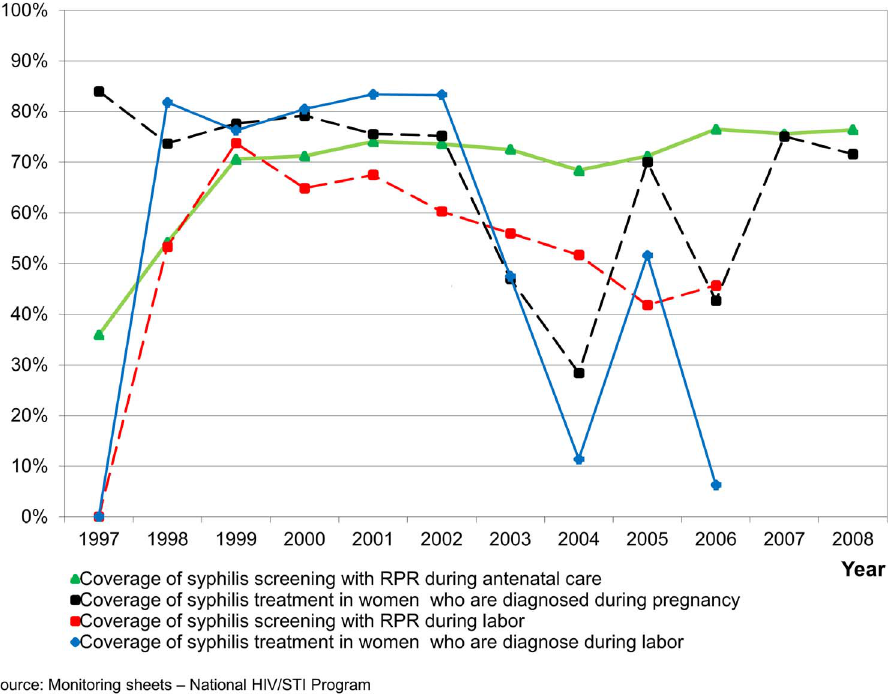
Figure 1. Syphilis screening and treatment in pregnant women, antenatal care and labor. Peru (1997–2008). Nationally the coverage for syphilis screening in pregnant women in antenatal care has been 75% since 2000, but treatment coverage for syphilis seropositive pregnant women fallen intermittently, from over 80% in 2000, to as low as 30% in 2004. Screening for syphilis for women during labor has been low as well as the treatment of women found seropositive in this situation.